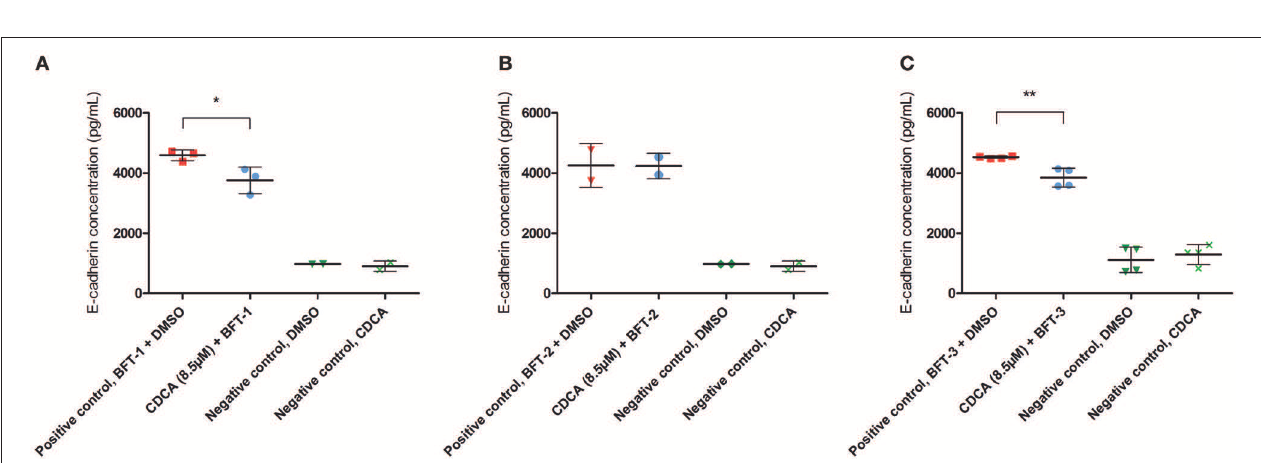
FIGURE 5 | CDCA inhibits E-cadherin cleavage induced by BFT-1 and BFT-3. The release of E-cadherin into the cell medium supernatant for 3h was measured with an E-cadherin ELISA. CDCA at 8.5 µ M led to an average 18% (unpaired t -test, P = 0.0389) (A) , 0% (B) , and 15% (unpaired t -test, P = 0.005) (C) reduction of E-cadherin concentrations in morphology assays with BFT-1 (A) , BFT-2 (B) , and BFT-3 (C) , respectively. Bars indicate means and standard deviations. BFT-1, N = 2–3, BFT-2, N = 2, and BFT-3, N = 4 (unpaired t -test, * P = 0.01–0.05; ** P = 0.001–0.01).